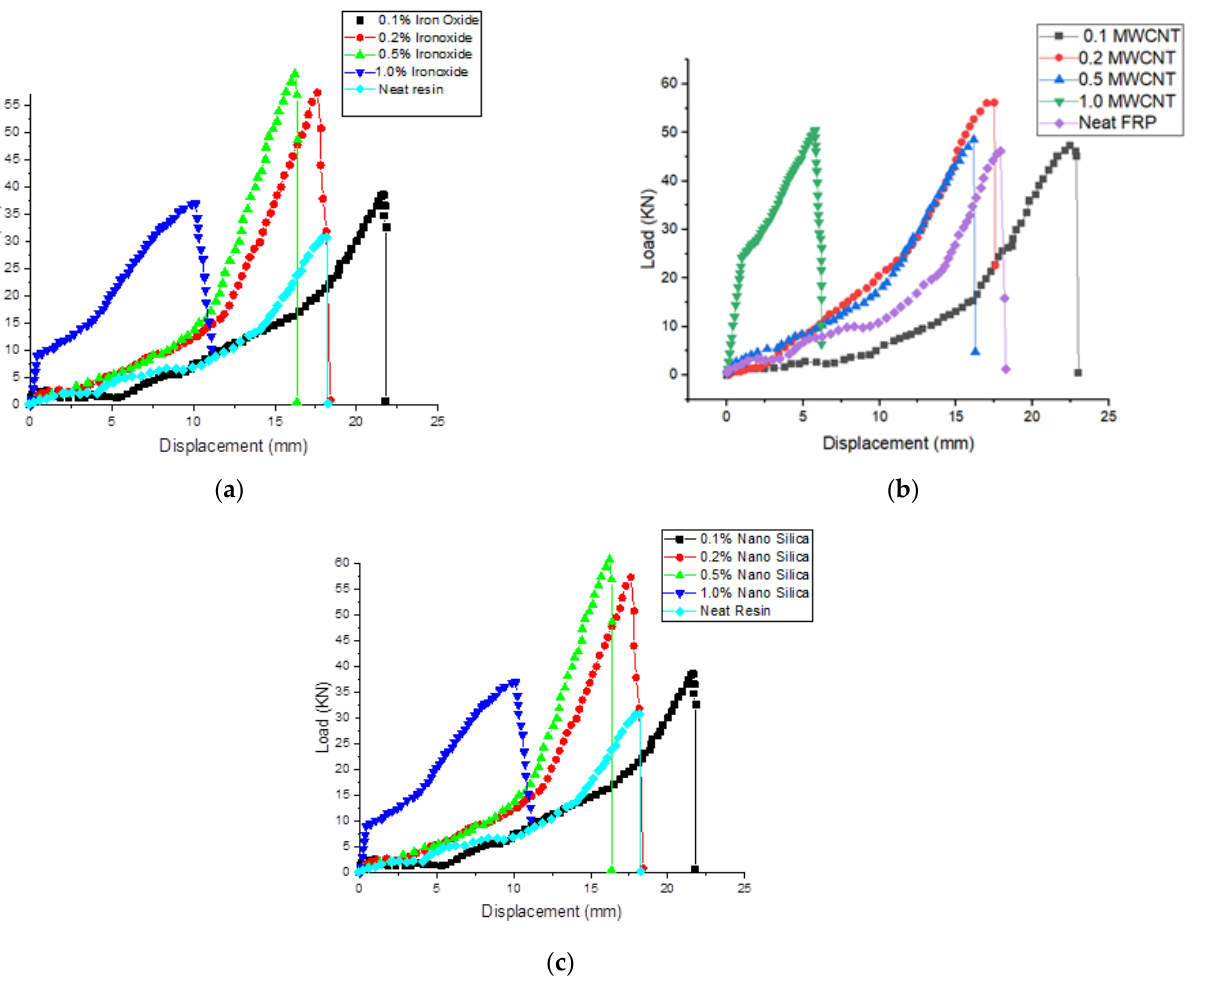
Figure 3. Load-displacement graphs of tensile tests for modified GFRP with ( a ) NFe, ( b ) MWCNTs, and ( c ) NS.